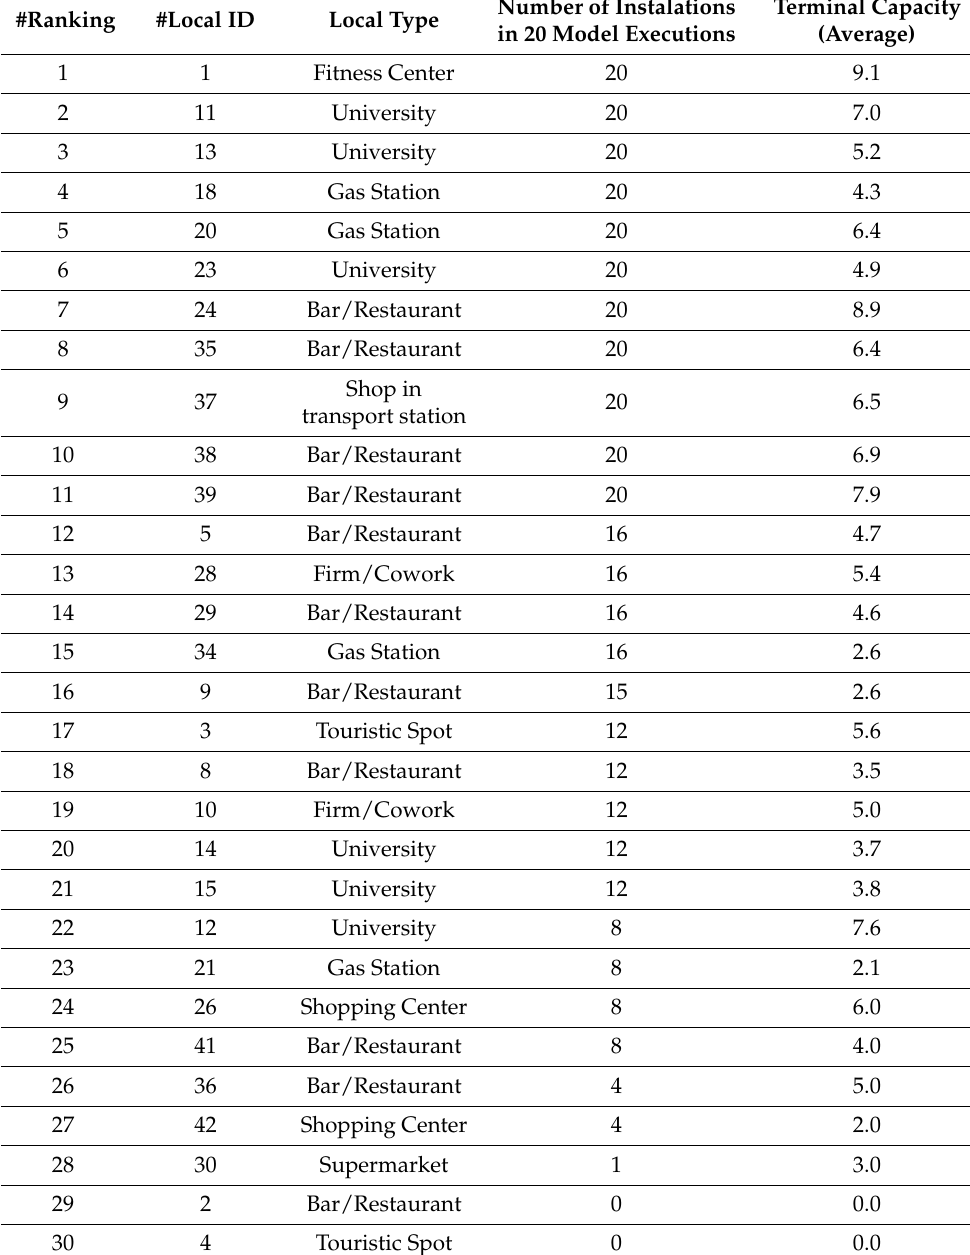
Table 14. Model results: Local ID, total installations, and average terminal capacity over twenty model